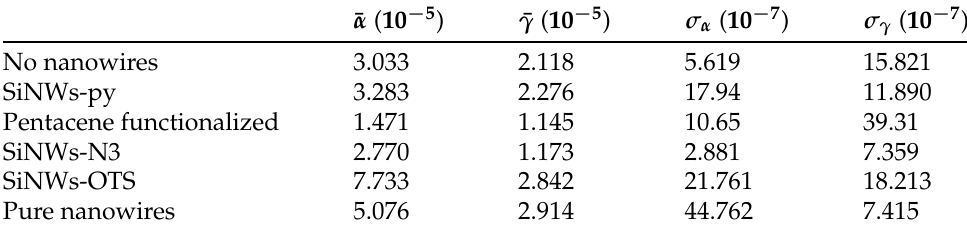
Table 3. Estimated coefficients α and γ for the different functionalized